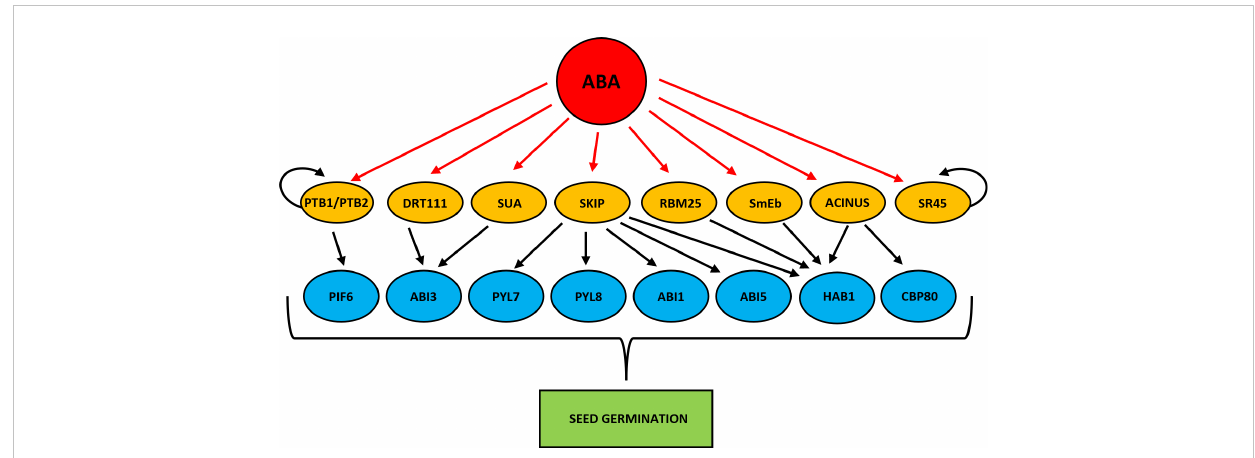
FIGURE 3 Scheme showing ABA-dependent splice factors that regulate alternative splicing of genes involved in the regulation of seed germination. Red arrows indicate ABA activation. Black arrows represent alternative splicing promotion. Curved arrows indicate autoregulation of alternative